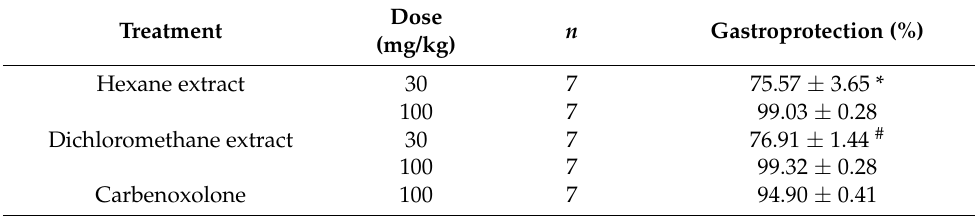
Table 1. Gastroprotective effects of the hexane and dichloromethane extracts. Treatment